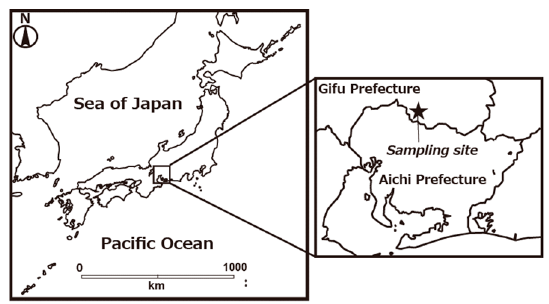
Figure 1. Maps showing location of the sampling site.